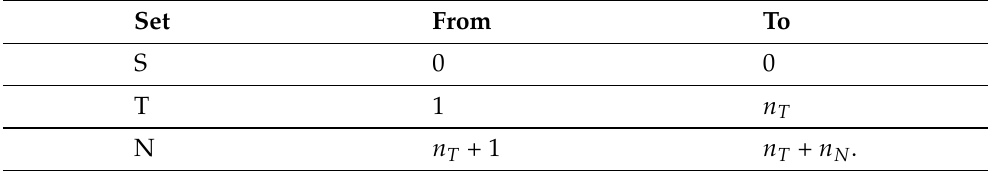
Table 1. Enumerated Symbols